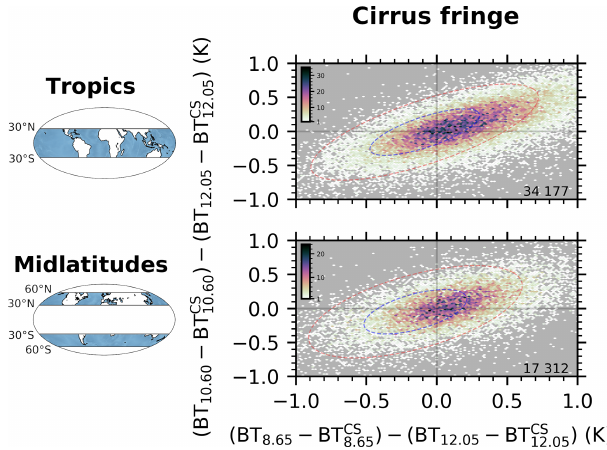
Figure 17. As Fig. 5 but for cirrus fringes with V4 special CAD score of 106, i.e., layers detected as aerosols by the V4 CAD al- gorithm first and then toppled to clouds by the V4 “cirrus fringe amelioration” algorithm (Liu et al., 2019). They mainly include a very thin layer (95% with τ < 0 . 2) and at high altitude (97% with z top > 8km in the tropics and 22% with 4km < z top < 8km and 78% with z top > 8km in the